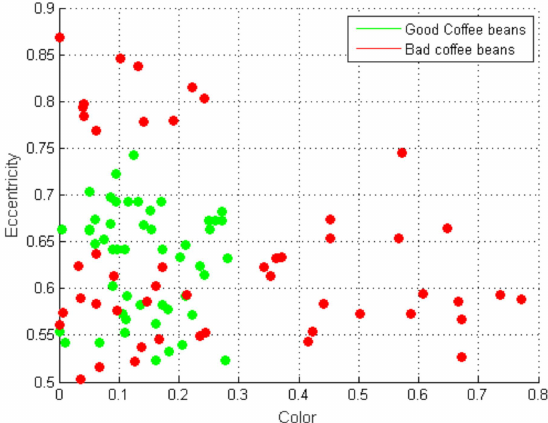
Figure 14. 2D plot of eccentricity and color features used for the k -nearest neighbor algorithm using the training set.